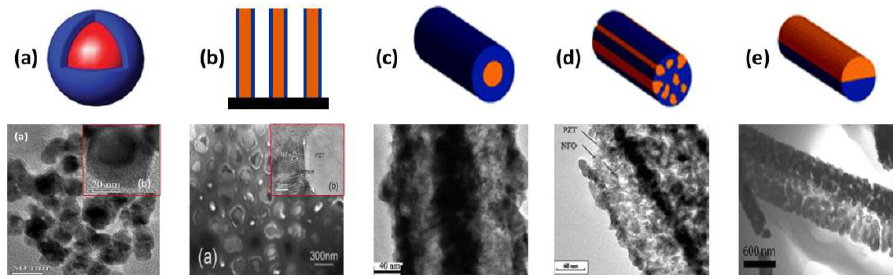
Figure 6. Bi-phasic ME composites with different types of arrangements between the two phases ( a – c ) core/shell arrangement: ( a ) nanoparticles [53], ( b ) nanowires [54], and ( c ) nanotubes [57]; ( d ) random arrangement [58], and ( e ) Janus-type arrangement [56].